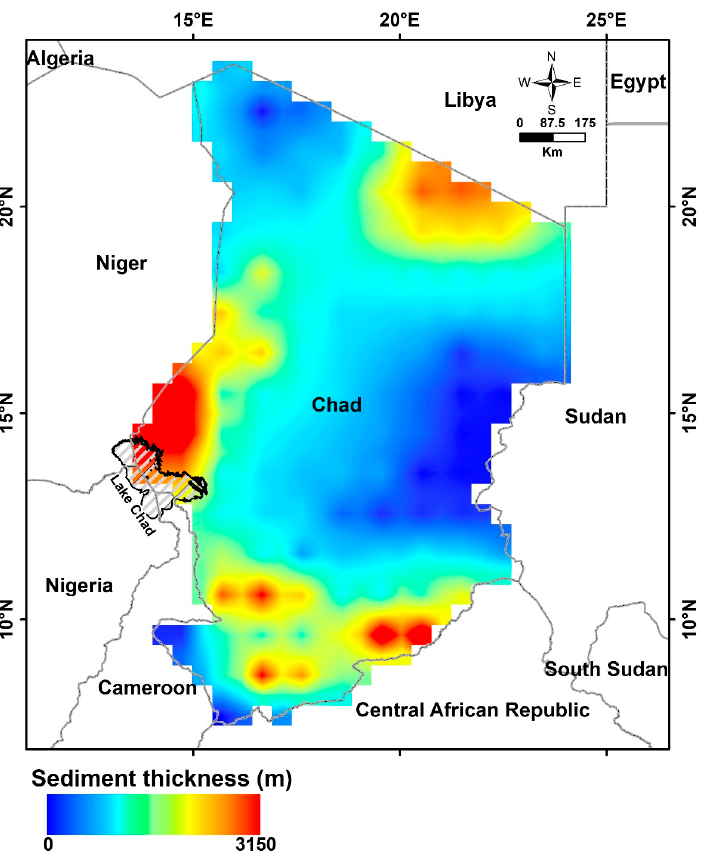
Figure 13. A representation of the sedimentary succession’s thickness (m) in Chad.